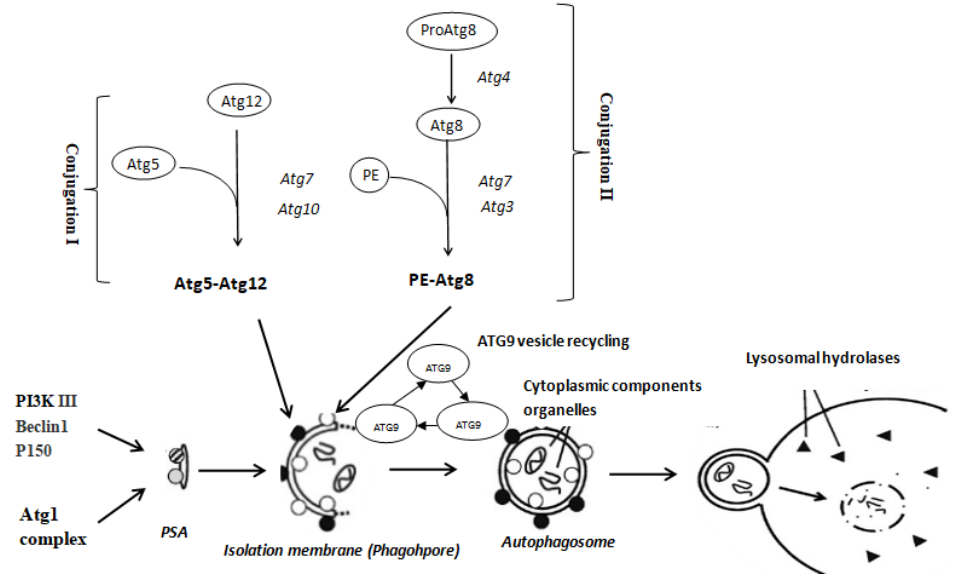
Figure 1. Schematic representation of the autophagy pathway from reference by Seiliez et al. (2010).